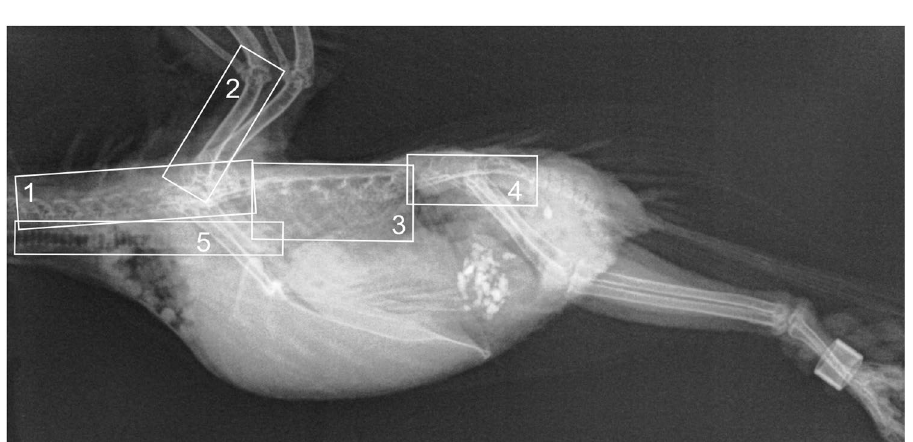
Figure 1. Laterolateral radiographic projection (AGFA DX-S detector, full dose at 40 kVp, 6.3 mAs) of a mouse where the regions for the criteria are defined. Criteria: 1 – Abdomen, 2 – Heart, 3 – Lung, 4 – Trachea, 5 – Spine.